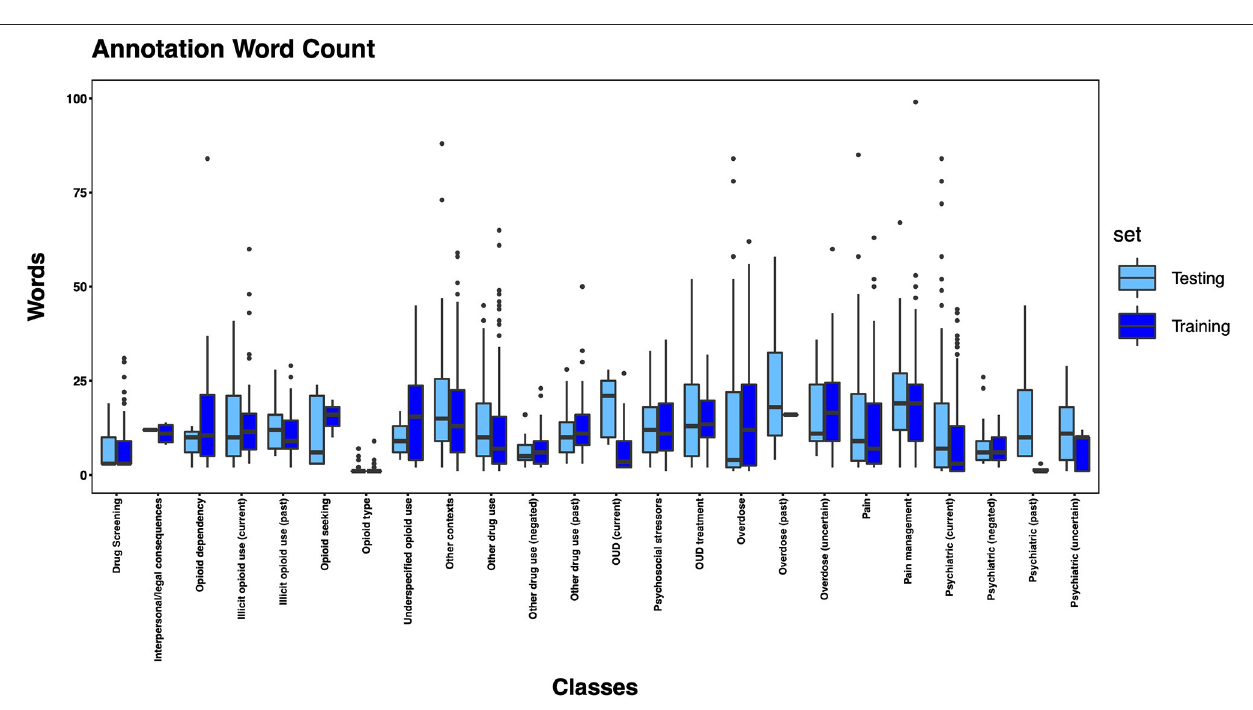
and “mja,” common short terms for alcohol and marijuana, respectively, were not encoded by the UMLS dictionary, resulting in reduced